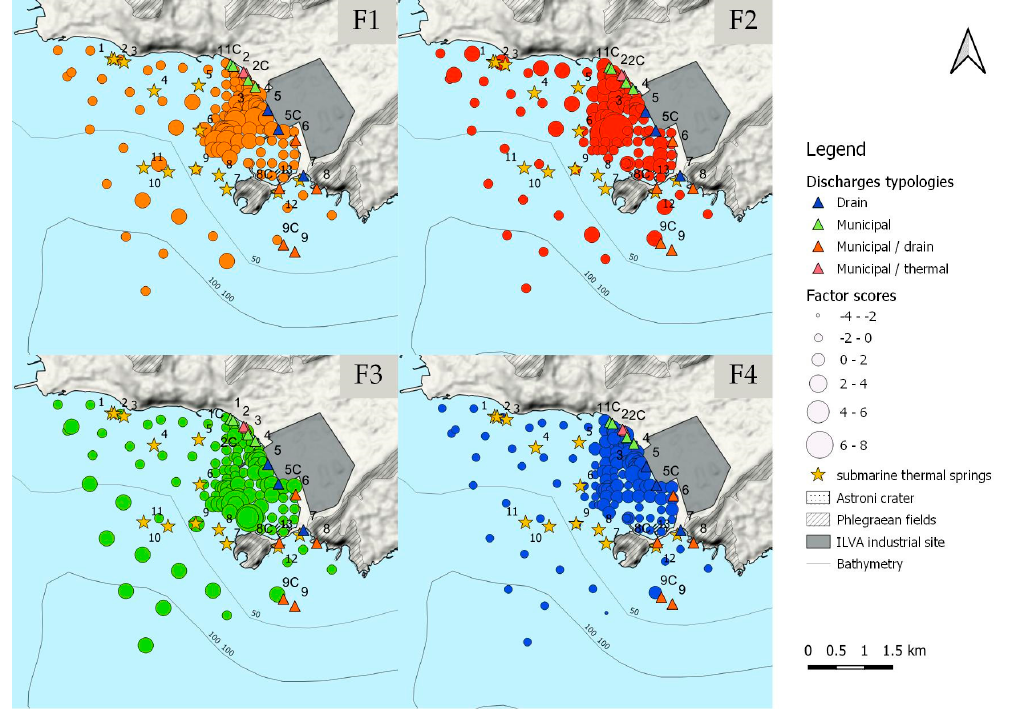
Figure 8. Representation of factor scores inside the bay. The interpolation of factor scores was made with the IDW (inverse distance weighting) method.